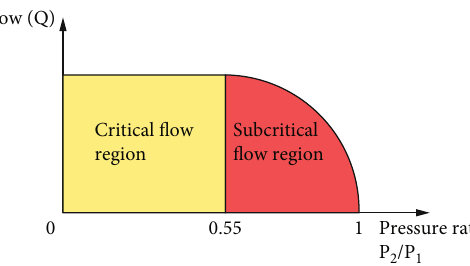
Figure 5: Flow characteristics of downhole